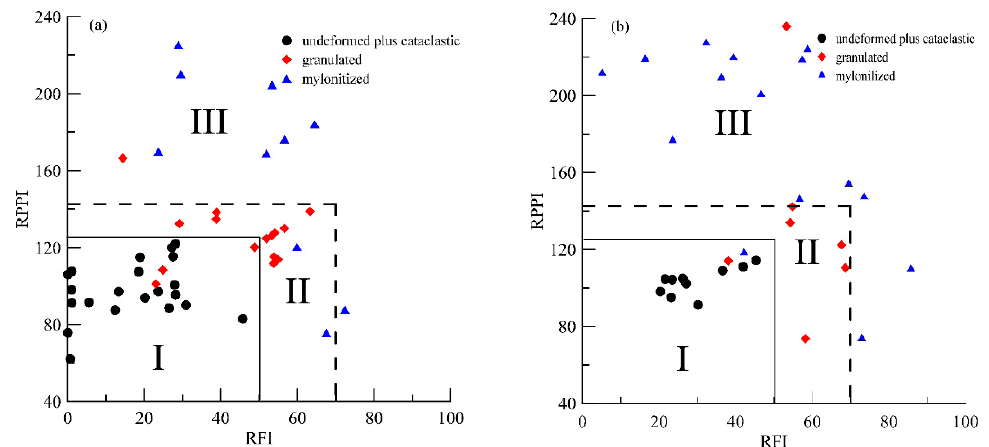
Figure 8. Cross plots of the RPPI versus RFI from the No. 11 ( a ) and No. 5 ( b ) coal seams. Table 5. Quantitative interpretation parameters and misjudgment rate of TDC.